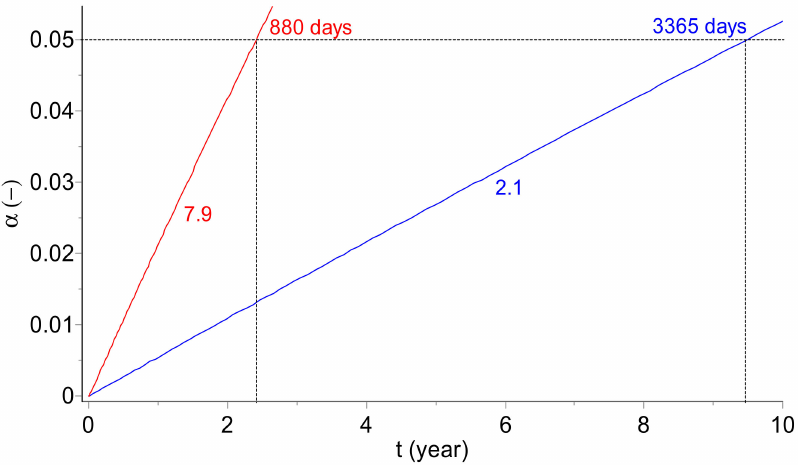
Figure 5. Model vaccine: Simulation of the long-term prediction of the change of the viral titer degree at temperatures of 2.1 and 7.9 ◦ C (marked on the curves) lying in the range of 2 to 8 ◦ C applied during the cold chain storage. Note the severe change of the vaccine shelf life (set arbitrarily as a time when 5% of the viral titer loss is reached) from 880 to 3365 days for 7.9 and 2.1 ◦ C, respectively, despite fulfilling the cold chain criterion in both